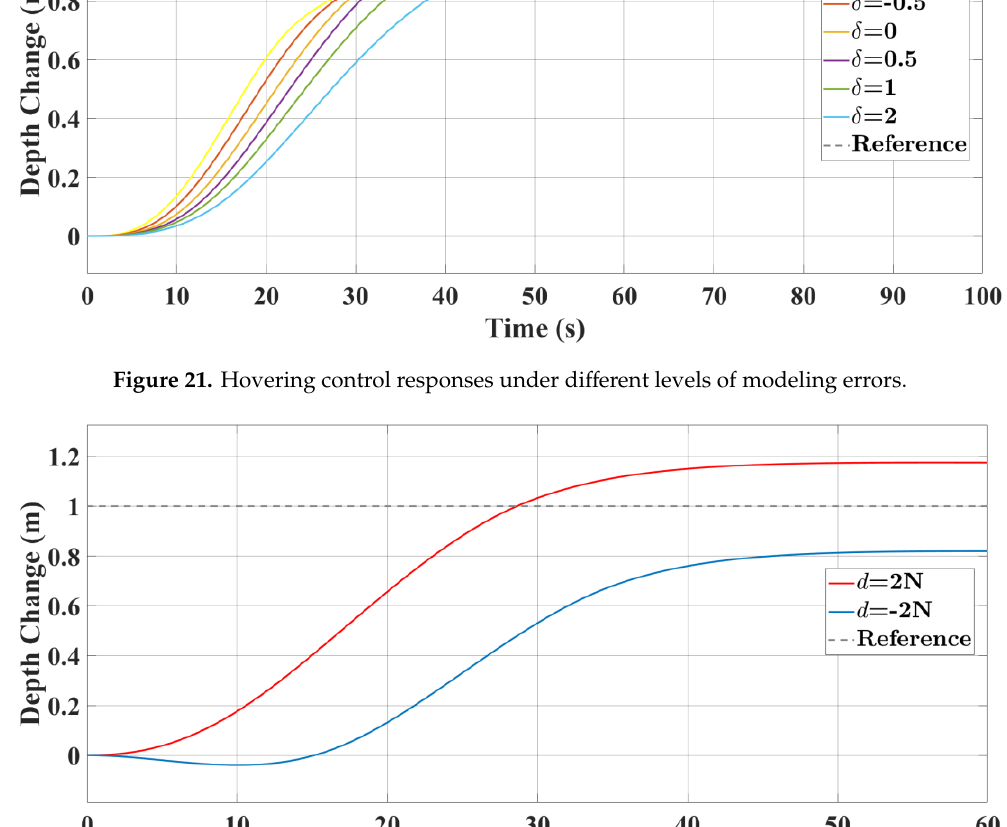
Figure 21. Hovering control responses under different levels of modeling errors.